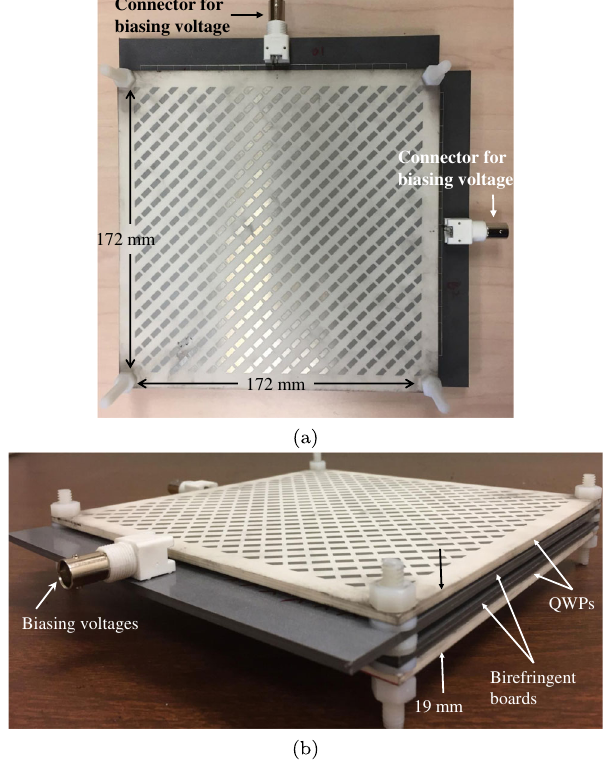
FIG. 14. Photographs of the fabricated tunable polarization rotator. (a) Top view. (b) Side view.